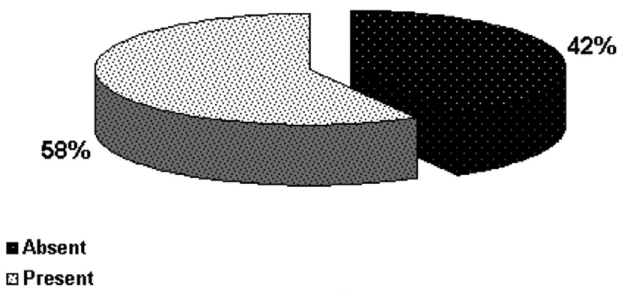
FIGURE 3 – Presence or absence of mandatory information in commercial